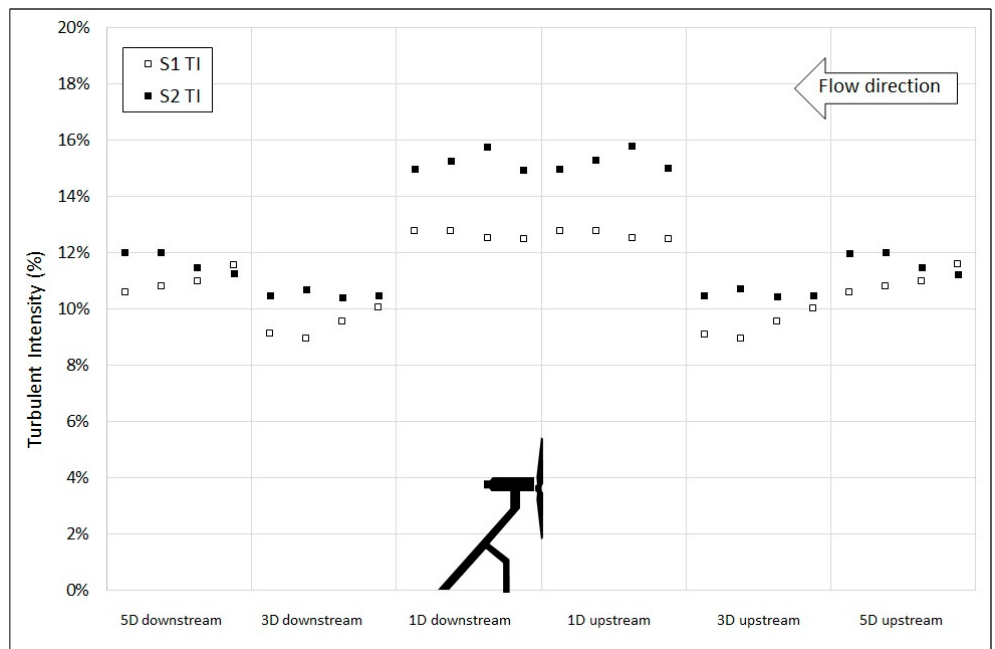
Figure 9. Resampled hub height turbulent intensity recorded at 1D, 3D and 5D upstream and 1D, 3D and 5D downstream of turbine mounted on S1 and S2 support structures (1024 samples at 25 Hz per point).